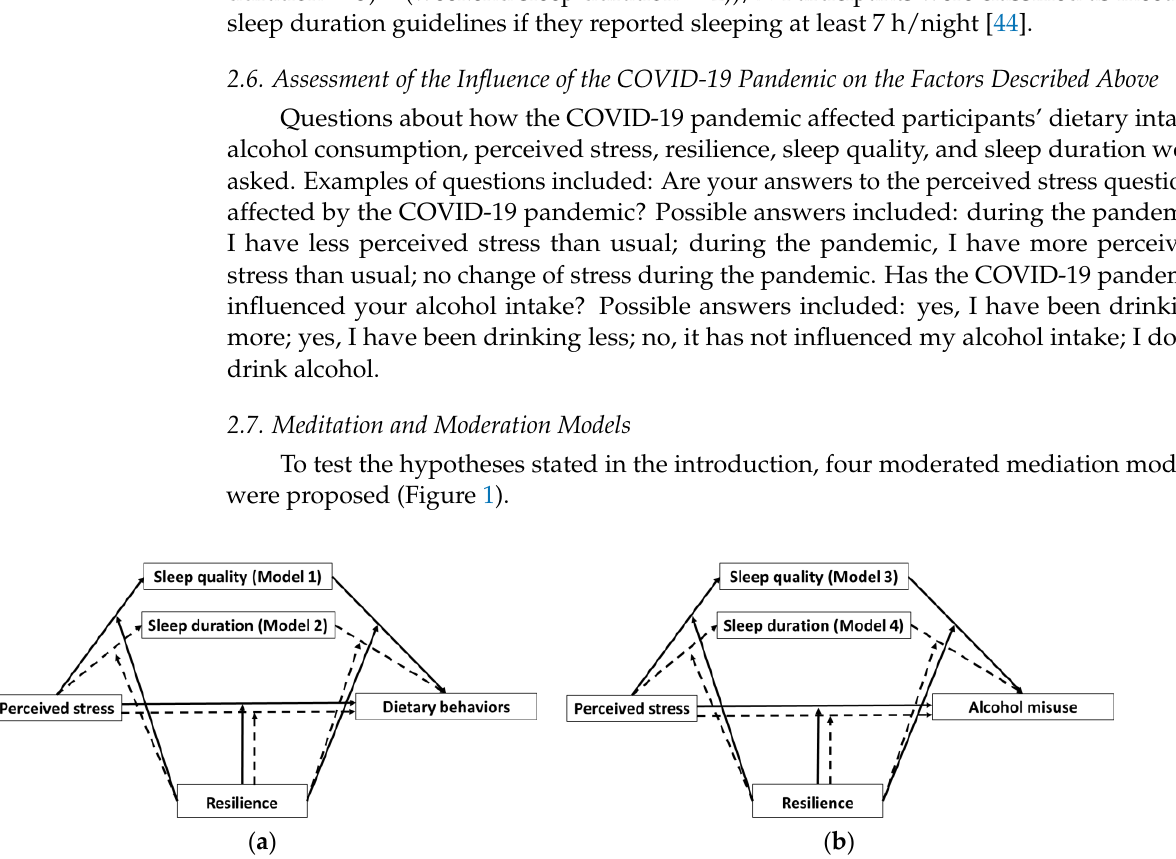
Figure 1. Proposed moderated mediation models. ( a ) Perceived stress on dietary behaviors through the mediation of sleep quality and the moderation of resilience (Model 1, solid line) and perceived stress on dietary behaviors through the mediation of sleep duration and the moderation of resilience (Model 2, dashed line). ( b ) Perceived stress on alcohol misuse through the mediation of sleep quality and the moderation of resilience (Model 3, solid line) and perceived stress on alcohol misuse through the mediation of sleep duration and the moderation of resilience (Model 4, dashed line).